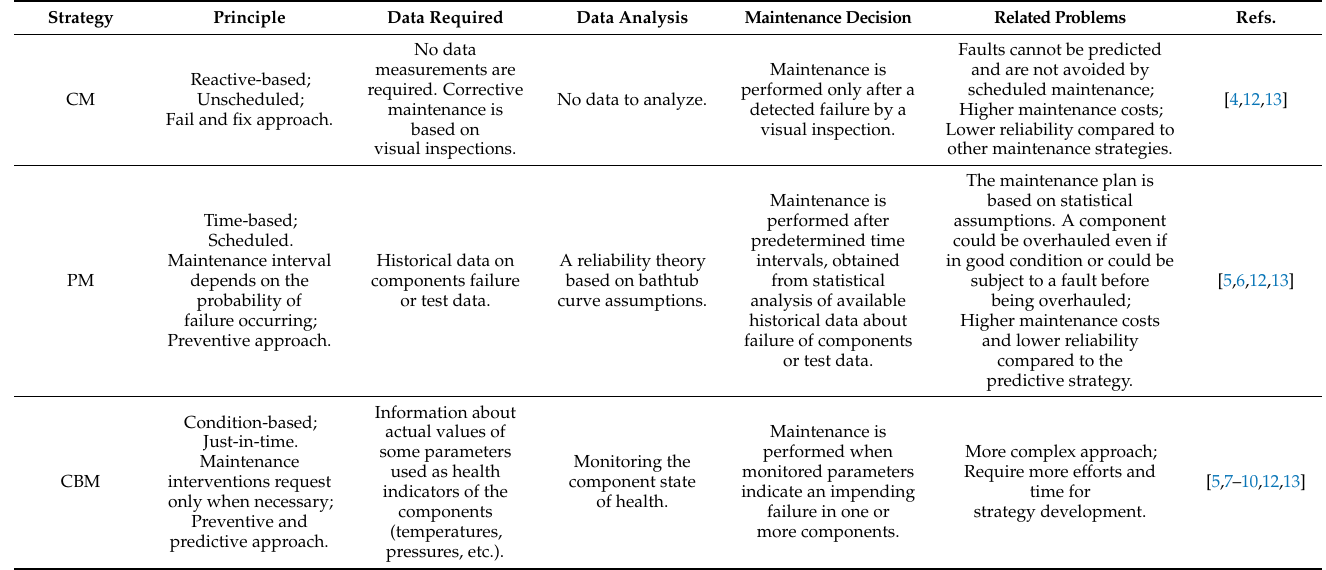
Figure 1. Maintenance strategies illustration. Table 1. Characteristics of the typical maintenance strategies.